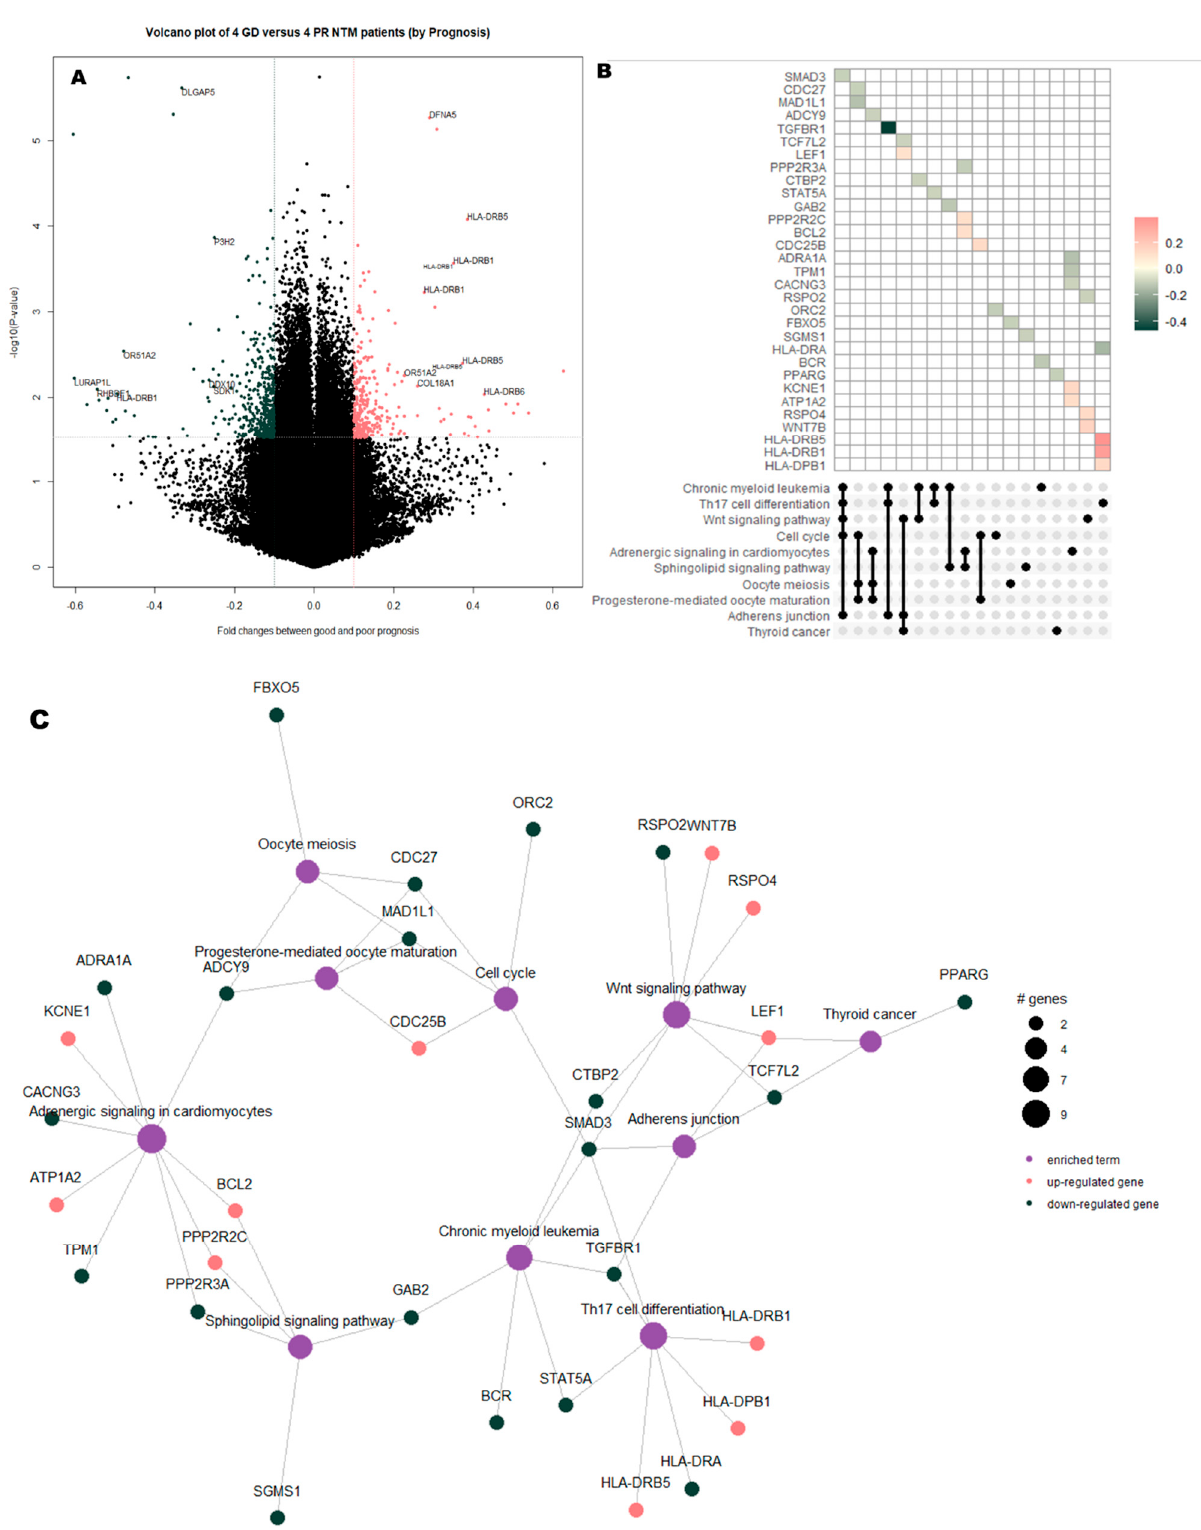
Figure 2. Enriched terms and functional enrichment network of the DMRs between NTM patients with good or poor prognosis. ( a ) Volcano plot illustrating DMRs (defined as a fold change in methylation >0.1 (red) or < − 0.1 (green) with P -value < 0.03) in NTM patients with poor prognosis. ( b ) Upset plot indicating the methylation patterns of 55 genes with 10 associated enriched terms. ( c ) Network plot: the color of the circles represents the methylation patterns in patients with NTM, and the size of the enriched circles represents the number of genes